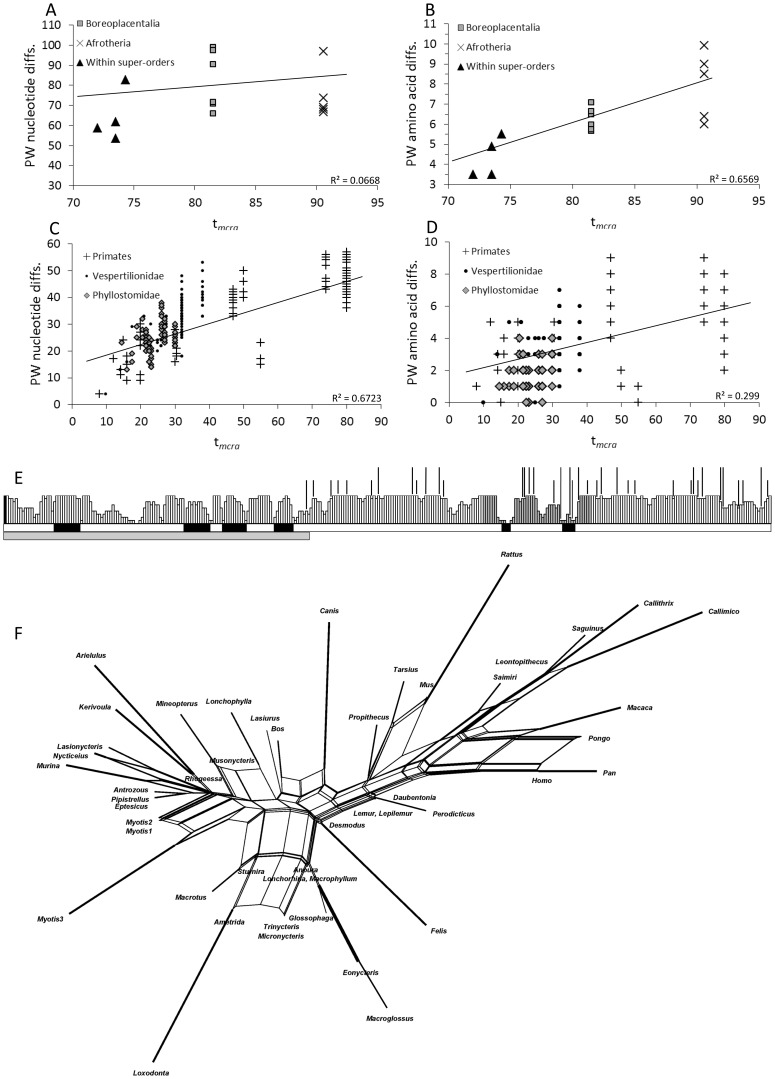
Patterns of PAX9 open-reading frame evolution.Although under tight purifying selection, PAX9 exhibits patterns of saturation and recurrent substitution contingent on the level of comparison (amino acid versus nucleotide) as well as the amount of evolutionary time considered in the data. A) and B) display the pairwise nucleotide and predicted amino acid differences among orders regressed against tmrca, respectively. C) and D) show similar plots, but among species from the families Phyllostomidae, Vespertilionidae and Miniopteridae, and the order Primates. E) Confidence in PSIPRED secondary structure prediction (greater confidence represented by larger bars) for each of the 341 residues of Pax9, and shading demarks exons. Directly below this histogram is the structural prediction in which white bars represent coiled structures and black represent helical regions. The solid grey bar at the bottom defines the limits of the paired-binding domain described by [7]. Vertical lines pointing to each codon position in the histogram indicate positions that vary across the mammalian taxa examined, and taller lines demark sights inferred to have accumulated recurrent substitutions. The number of inferred substitutions at these sights from left to right are as follows: 3, 2, 3, 2, 7, 4, 3, 4, 8, 6, 3, 2, 4, 4, 2, 3, 2, and 5. F) Reticulation network based on predicted amino acid translations. Closed loops in the network indicate homoplasies, and edge thickness is in proportion to bootstrap support.